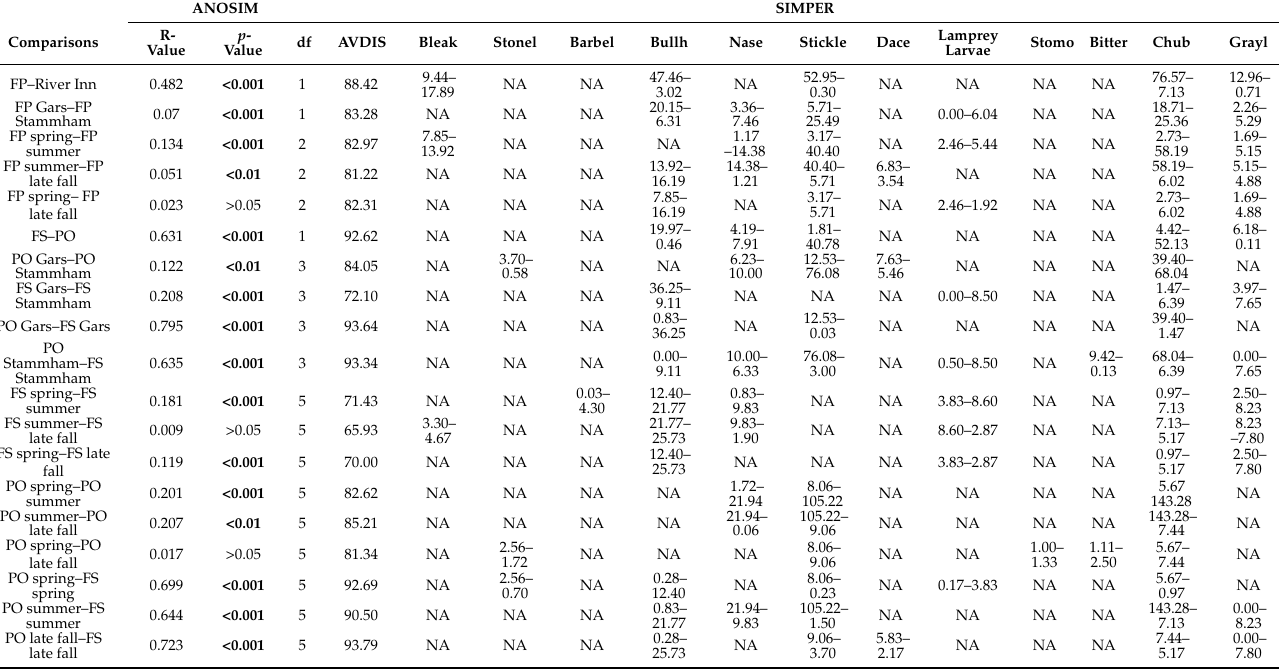
Numbers in bold indicate significant differences for pairwise